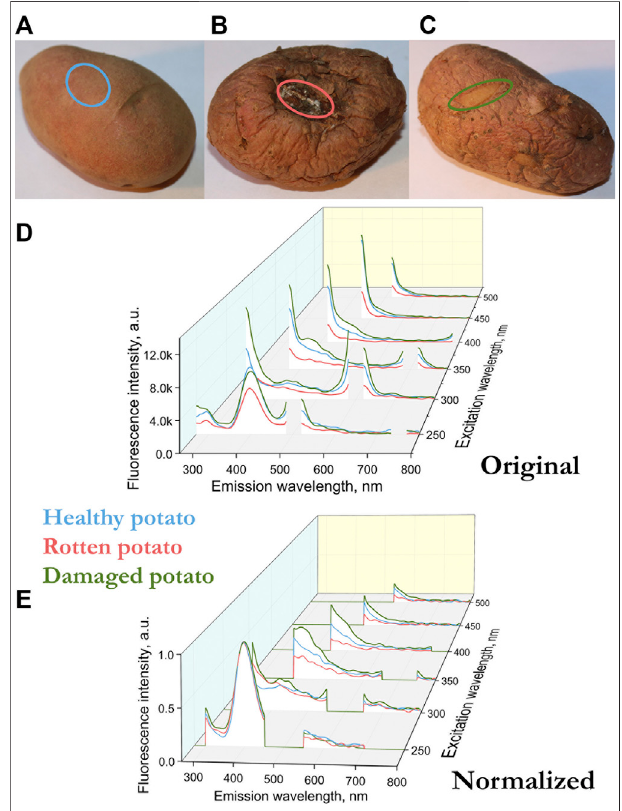
FIGURE 2 | (A) Sampling areas for healthy potatoes (blue), (B) when rotting(red), (C) aplaceofmechanicaldamage,anewskinhasgrowninplace of the damaged one (green). (D) Fluorescence spectra of the surface of the potato variety Kumach (blue), with rotting (red), a place of mechanical damage with a new skin (green). (E) Normalized by the height of the peak at a wavelengthof400 nm(excitation250 nm) fl uorescencespectraofthesurface of the potato variety